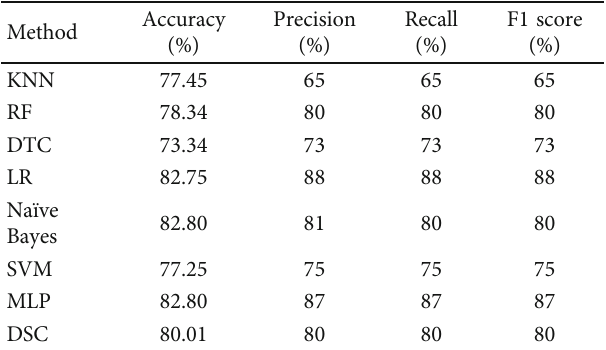
Table 6: A description of the success metrics compared to baseline classi fi ers using the women ’ s clothing dataset for the proposed approach.